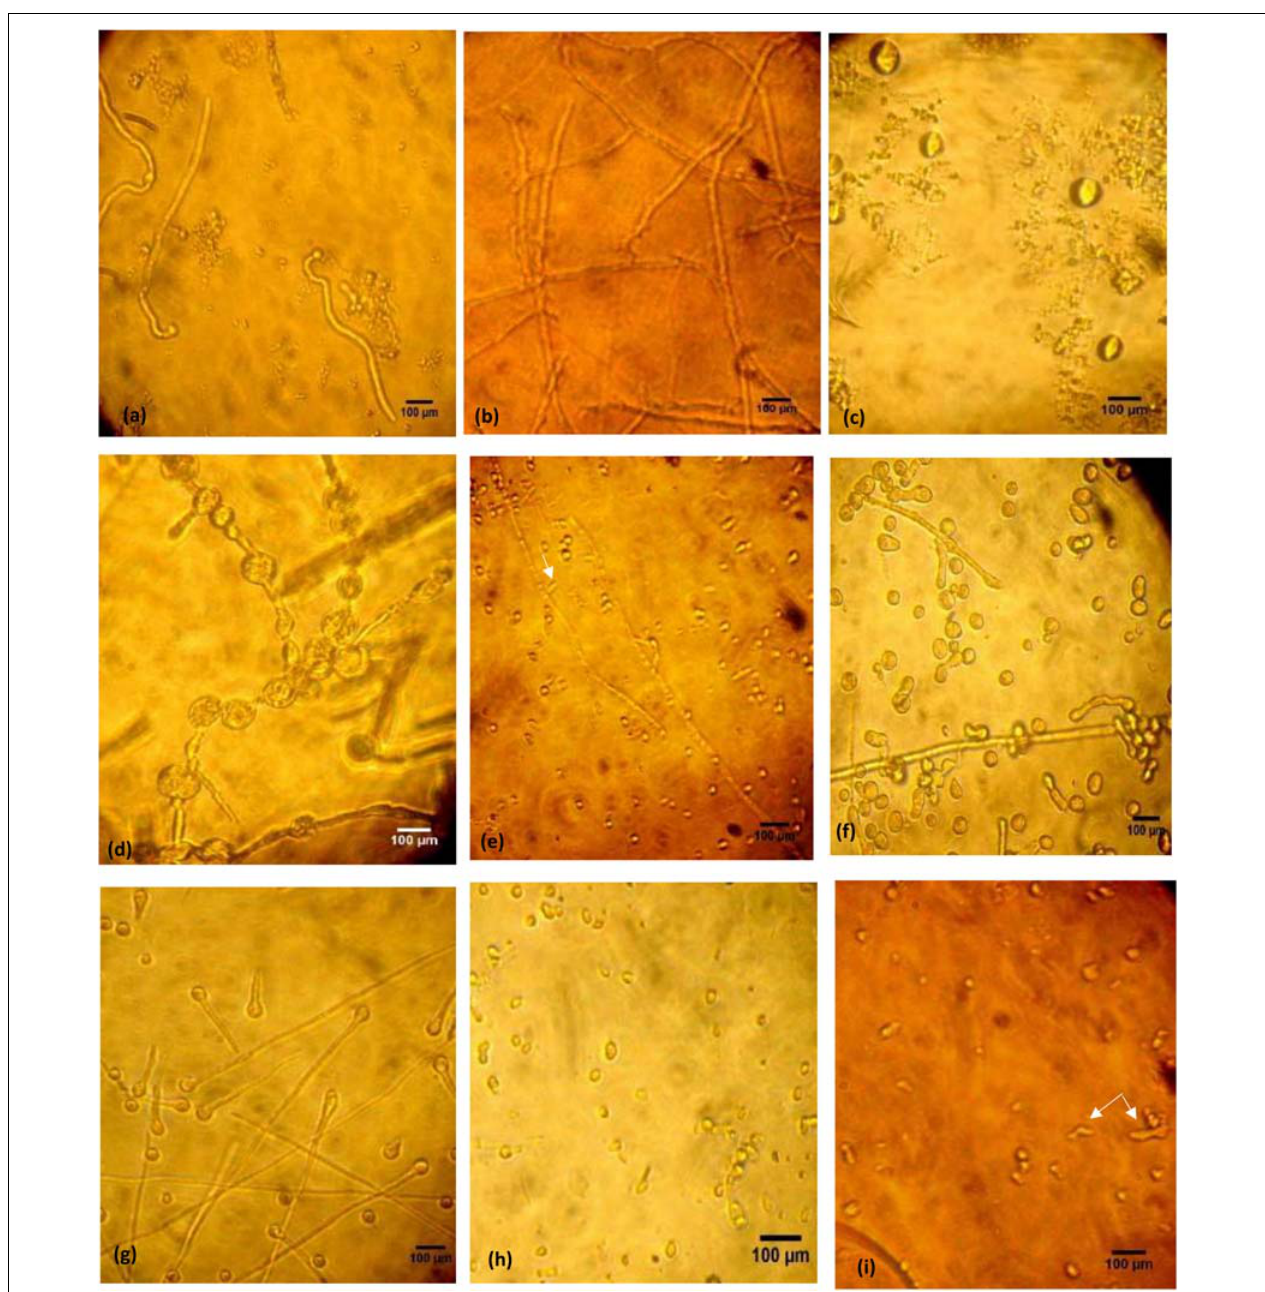
FIGURE 1 | Microphotographs of control and treated T. rubrum grown in RPMI during 72 h at 30 ◦ C, using inverted phase-contrast microscope, 400 × (bar 100 µ m). Untreated fungus showing initiated germination 4 h following incubation of spores (a) . Normal forms of hyphae after 72 h (b) . Miconazole treated cells showing different modifications after 72 h; formation of conidia in 1 mg/L (c) , thick wider hyphae with vacuoles in 0.5 mg/L (d) , thin long hyphae with tear-shaped microconidia (arrow) in 0.25 mg/L (e) . Chlamydospore formation in 20% urea treated cells after 72 h (f) . Germination of spores in 10% urea treated cells (g) . Inhibition of spore germination by a combination of 20% urea and 0.004 mg/L miconazole detected after 72 h (h) . Deformities, cellular damages, and short necrotic hyphae (arrow) in 20% urea and 0.002 mg/L miconazole combination (i) .